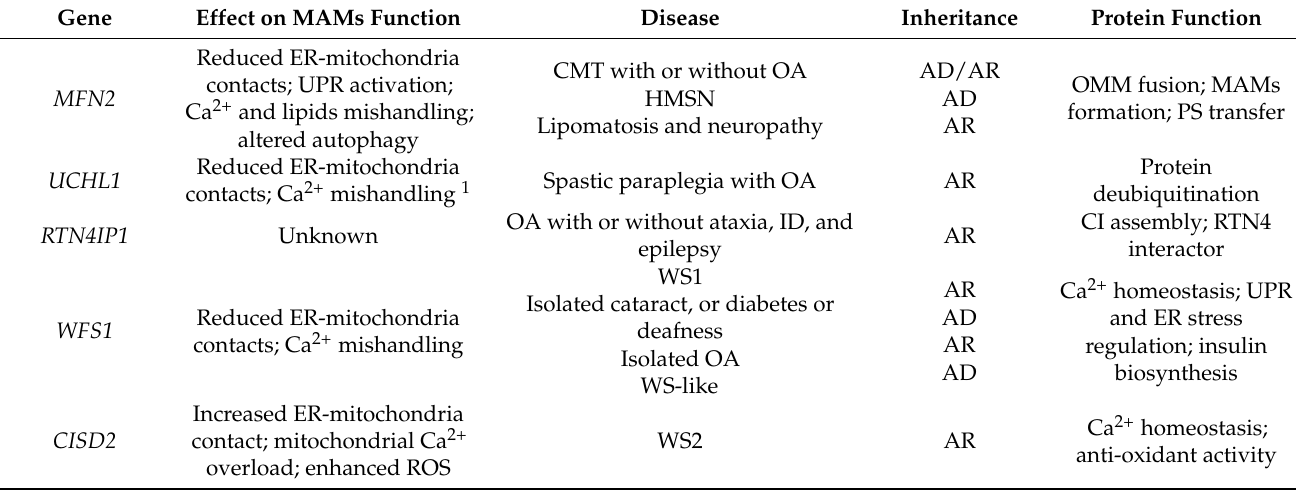
Table 3. Main nuclear genes associated with mitochondria-associated membranes dysfunction leading to optic atrophy.